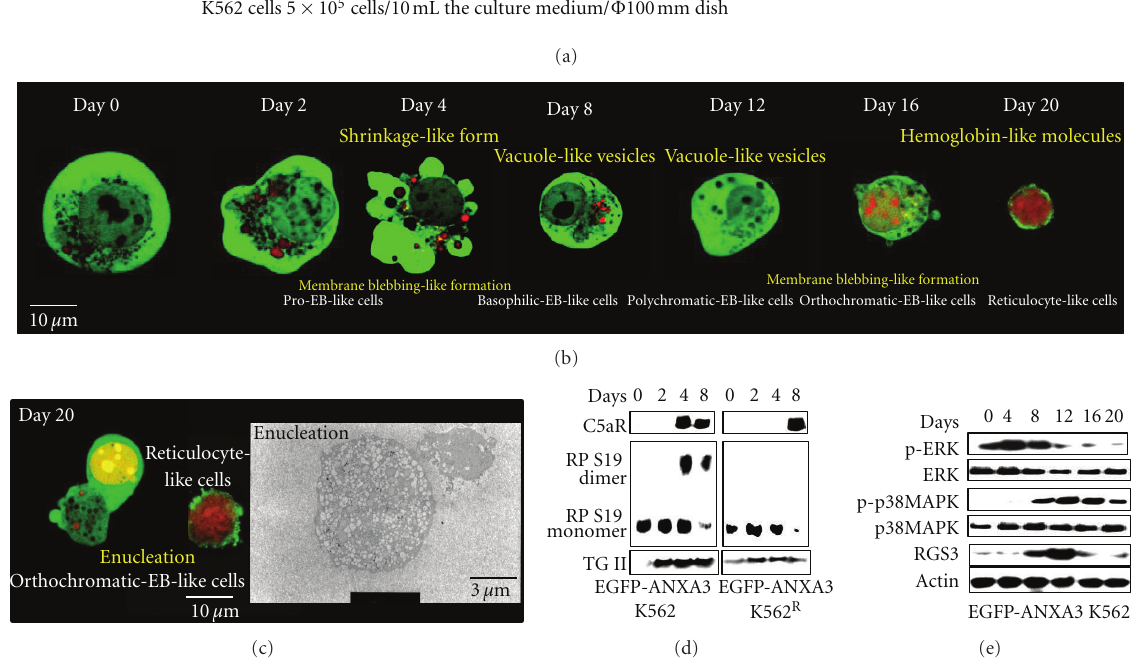
Figure 2: Contribution of the C5aR-RP S19 oligomer system to the haemin-induced di ff erentiation of K562 cells under monocell culture conditions (a) Time schedule for the K562 monocell culture. ((b) and (c)) K562 cells expressing EGFP-ANXA3 were observed under CLSM or TEM at several time points after the haemin induction ( n = 6). ((d) and (e)) EGFP-ANXA3-expressing K562 and K562 R cells were harvested at several time points after the haemin induction. After transferring the proteins from the SDS gel onto the membrane, the first immunoblotting was performed using the rabbit IgGs against C5aR, RP S19, and TGII (d) or ERK1/2, p38MAPK, RGS3, and actin (e) ( n =